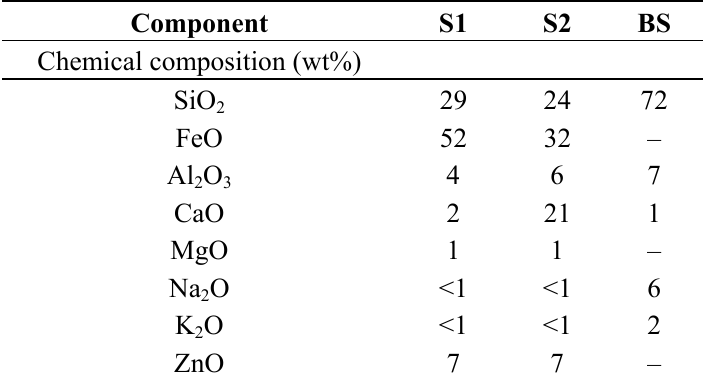
1. Chemical composition of starting slags and recycled glass. S, slag; BS, borosilicate